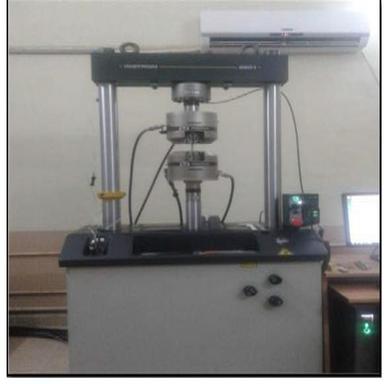
Tensile testing of 9% sample.